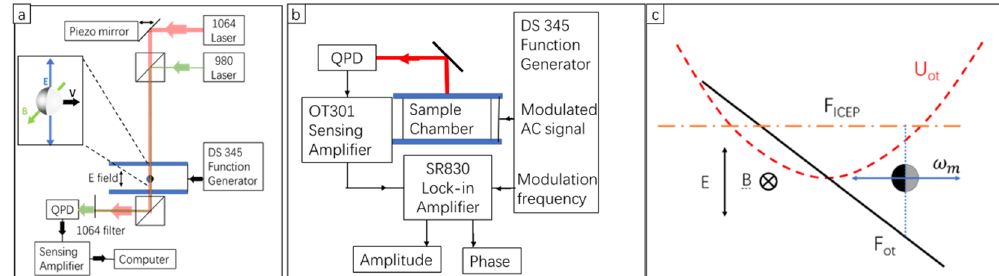
Figure 4. Phoretic force spectroscopy (PFS) set-up and force diagram. ( a ) Lightpath diagram of PFS. A 1064 nm laser was used to trap a Janus particle. A 980 nm tracking laser was co-aligned with a 1064 nm trapping laser. The 980 nm tracking laser was detected by a quadrant photodiode (QPD). A magnet provided an in-plane magnetic field to further align the Janus Particles (insert). ( b ) Signal chain diagram. A lock-in amplifier analyzed the signal of particle position with the modulation signal as a reference. ( c ) Force diagram of an optically trapped Janus particle under a modulated AC electric field. U ot is the potential of a particle in the trap. F ICEP (active force) and F ot (trap force) are in balance at a non-center spot. Electric field (E) is in the z-direction, and the magnetic field is in the y-direction. The orientation of the Janus particle is in the x-direction. The particle oscillates, and the oscillation frequency is the same as the frequency of the modulation signal.